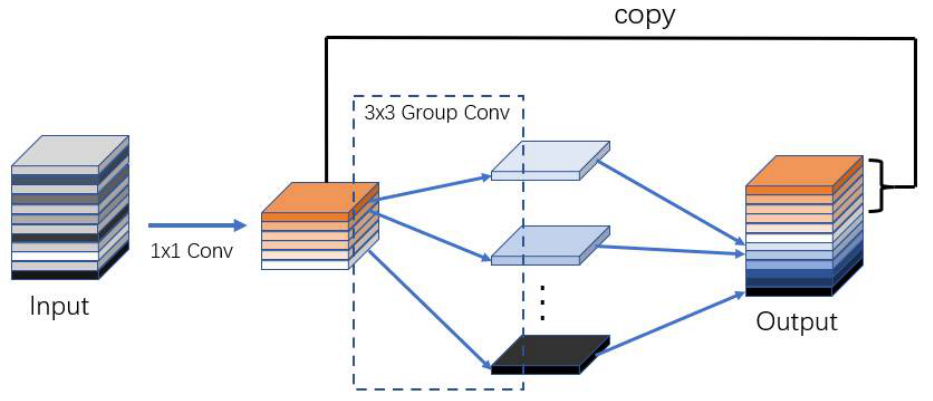
Figure 3. Ghost module sketch map.